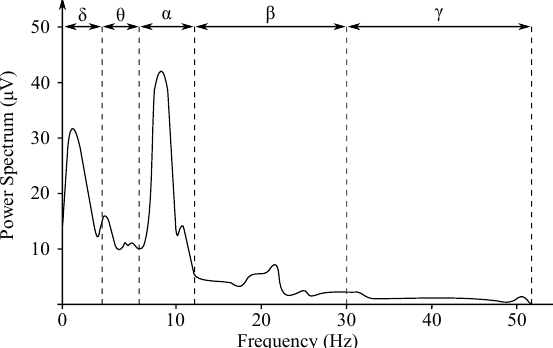
Figure 4. EEG frequency spectrum and its frequency bands [31].